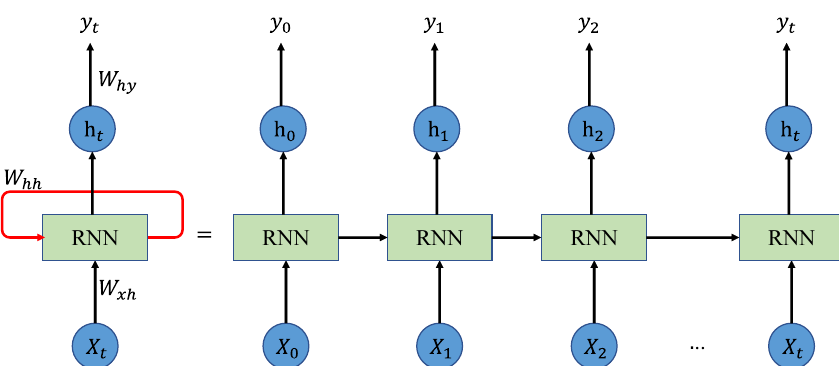
Figure 1. The structure of a simple recurrent neural network (RNN).